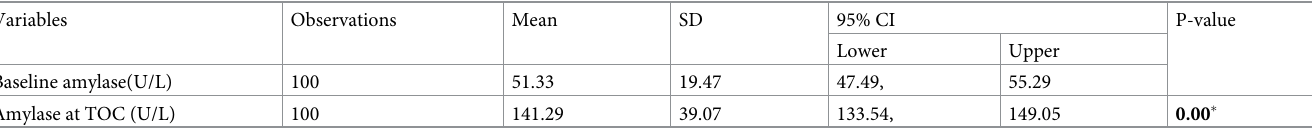
Table 2. Comparison of serum amylase before and after treatment using paired t-test. Variables